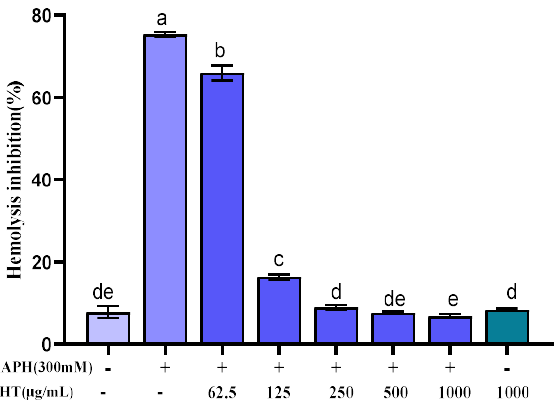
Figure 8. Inhibitory effects of various concentrations of FML on AAPH-induced erythrocyte hemoly- sis (Note: The same small letters indicate no significant difference between groups, different small letters indicate a significant difference between groups, p <